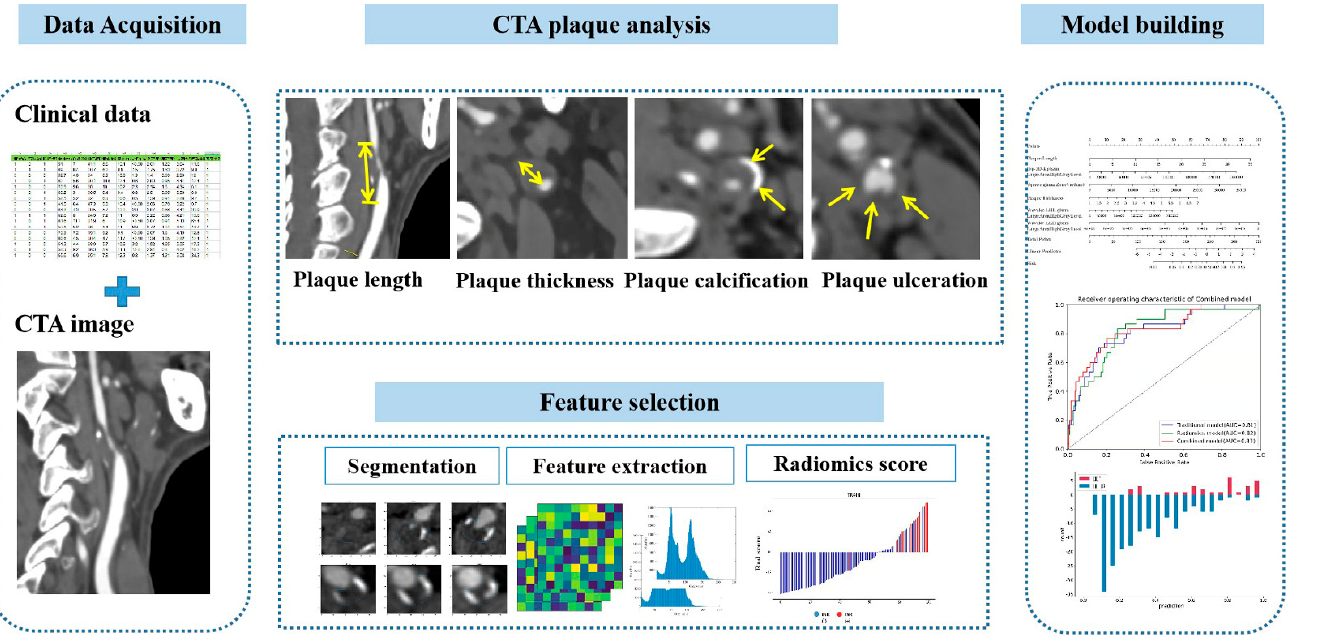
Figure 1. A flowchart of model development. Clinical, laboratory, and imaging data were collected and plaque analysis was performed on carotid CTA. Manual segmentation was performed using an axial slice that best represents the plaque features. The backward likelihood ratio elimination method was used to determine the most important and independent discriminating features. Selected radiomics features were used to build radiomics models. The model was evaluated using the area under the receiver operating feature curve for the training and validation cohorts. The predictive power of the classifier was assessed by 5-fold cross-validation.